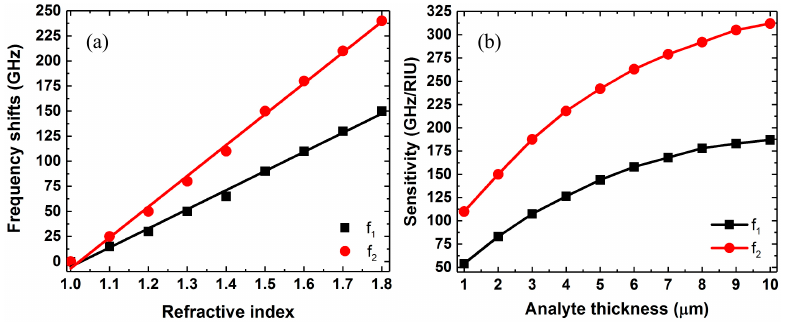
Figure 4. Panel ( a ): the frequency shift as a function of the refractive index of a 5 μ m thick analyte adsorbed on the MS. Panel ( b ): the dependence of the sensitivity respect to the variation of the analyte thickness for a refractive index equal to